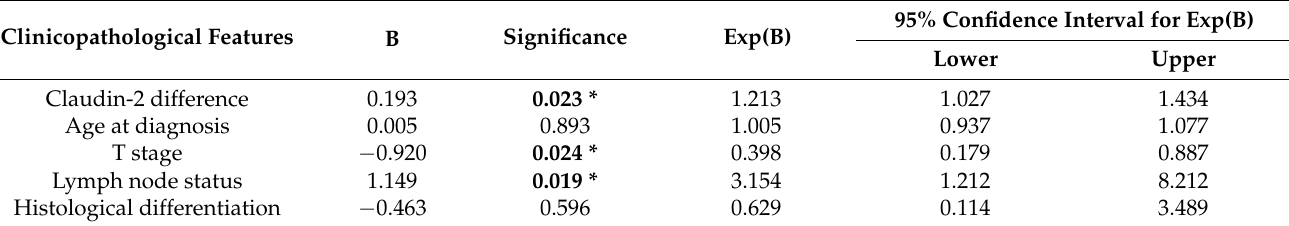
Table 3. Cox multi-regression